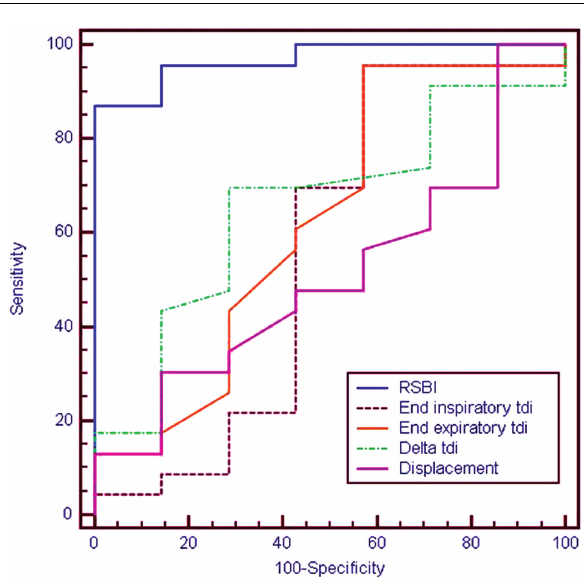
Receiver operating characteristic curve for different parameters to predict outcome (success). RSBI, rapid-shallow